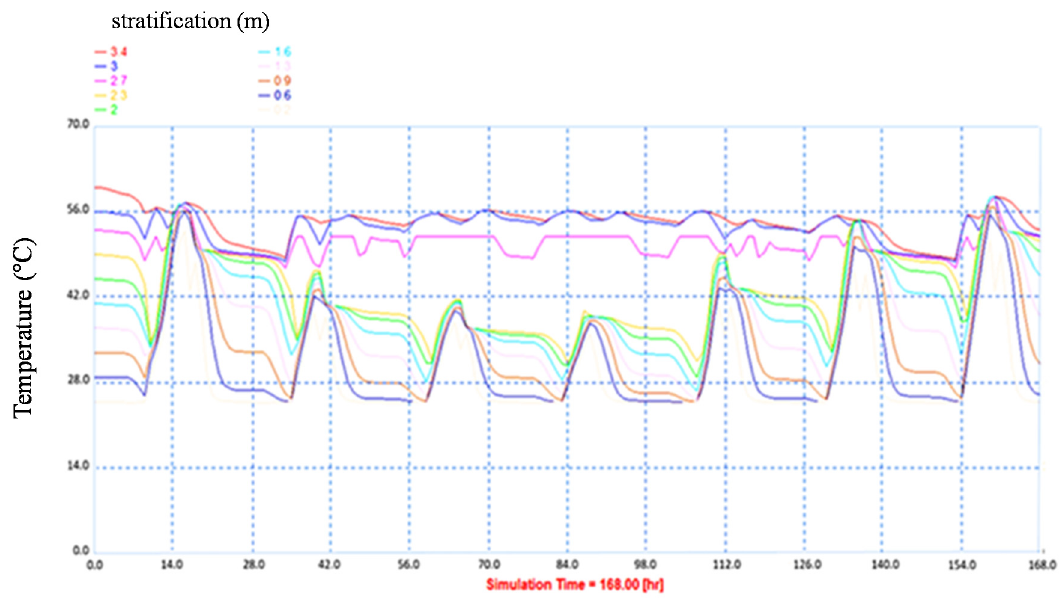
Figure 9. TRNSYS simulation for the winter season of the temperature stratification in the tank.